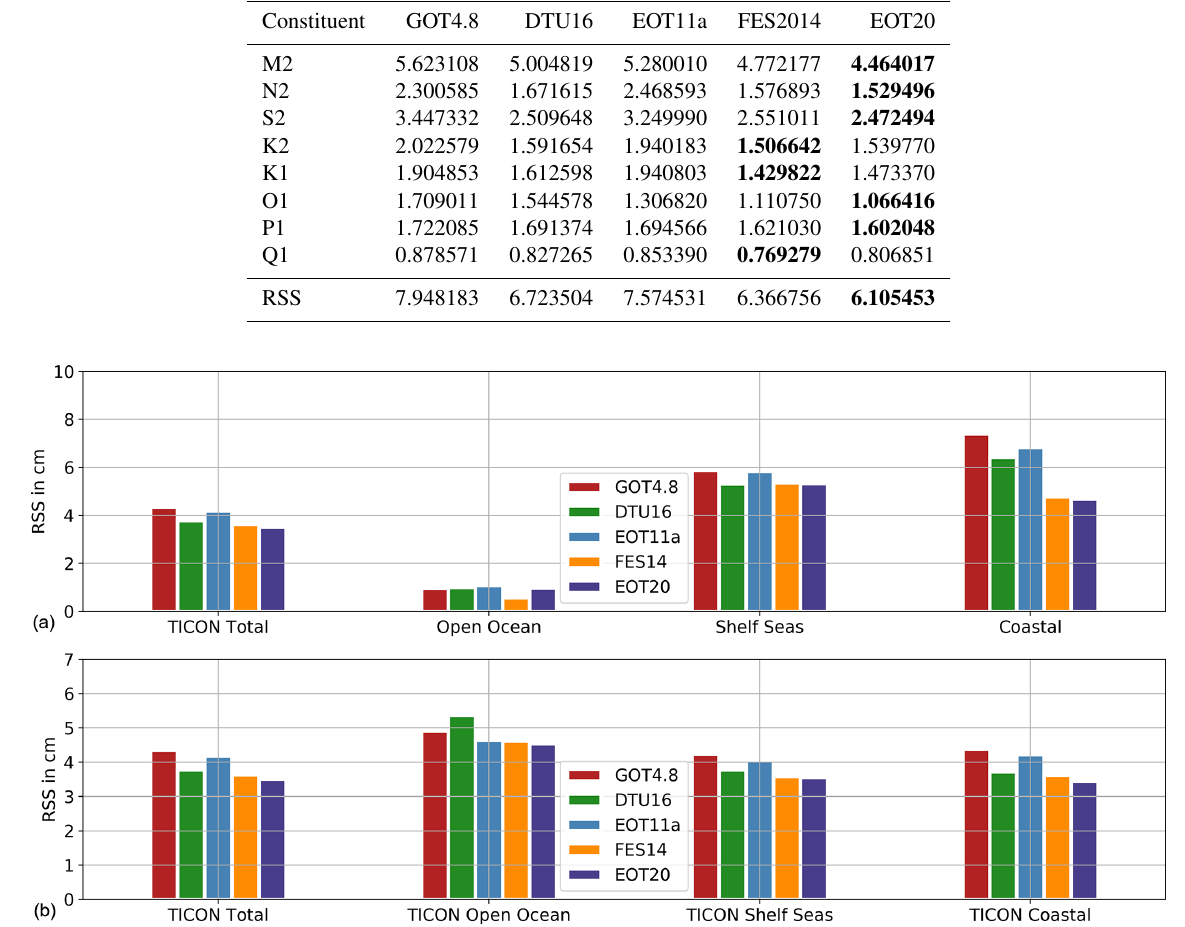
Figure 5. (a) RSS (cm) between the tide gauge databases and the global tidal models, for the eight major tidal constituents. (b) The RSS of subset regions of the TICON database as well as the full